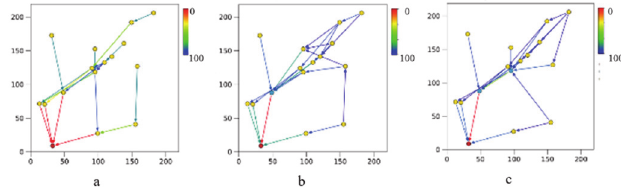
Fig. 2. The distribution of the remaining energy in network